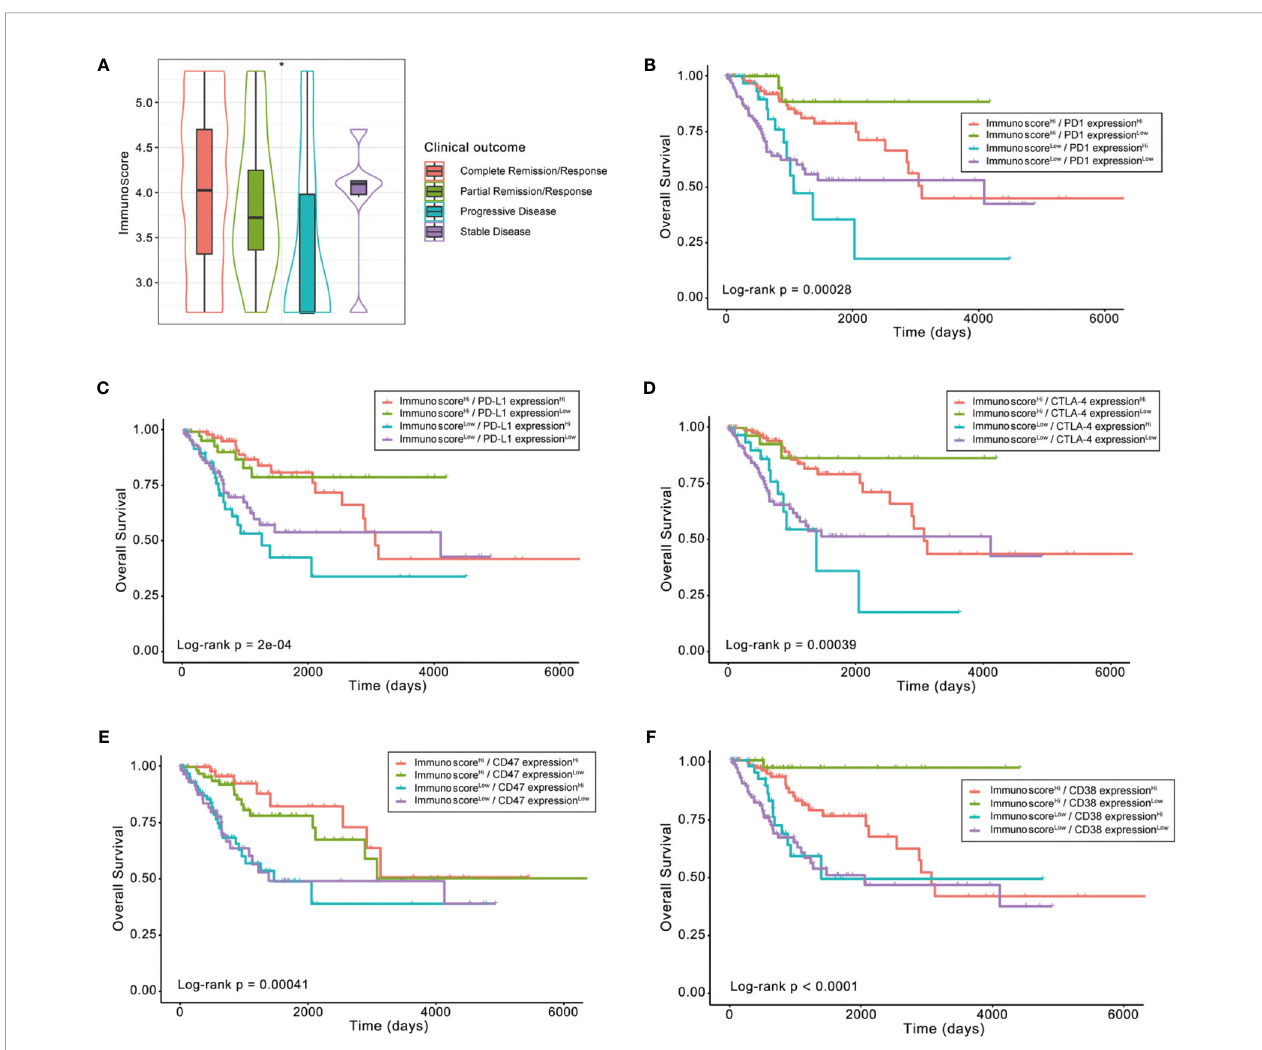
FIGURE 8 | The role of Immunoscore in the prediction of immunotherapeutic bene fi ts. (A) Difference in Immunoscore distribution between patients with different outcomes after fi rst course of treatment (Kruskal – Wallis test p < 0.05). (B – F) Kaplan – Meier curves for patients in the TCGA-CESC cohort strati fi ed by both Immunoscore and expressions of immune checkpoints, such as PD1, PD-L1, CTLA-4, CD47, and CD38. Log-rank test, p < 0.001, *p <